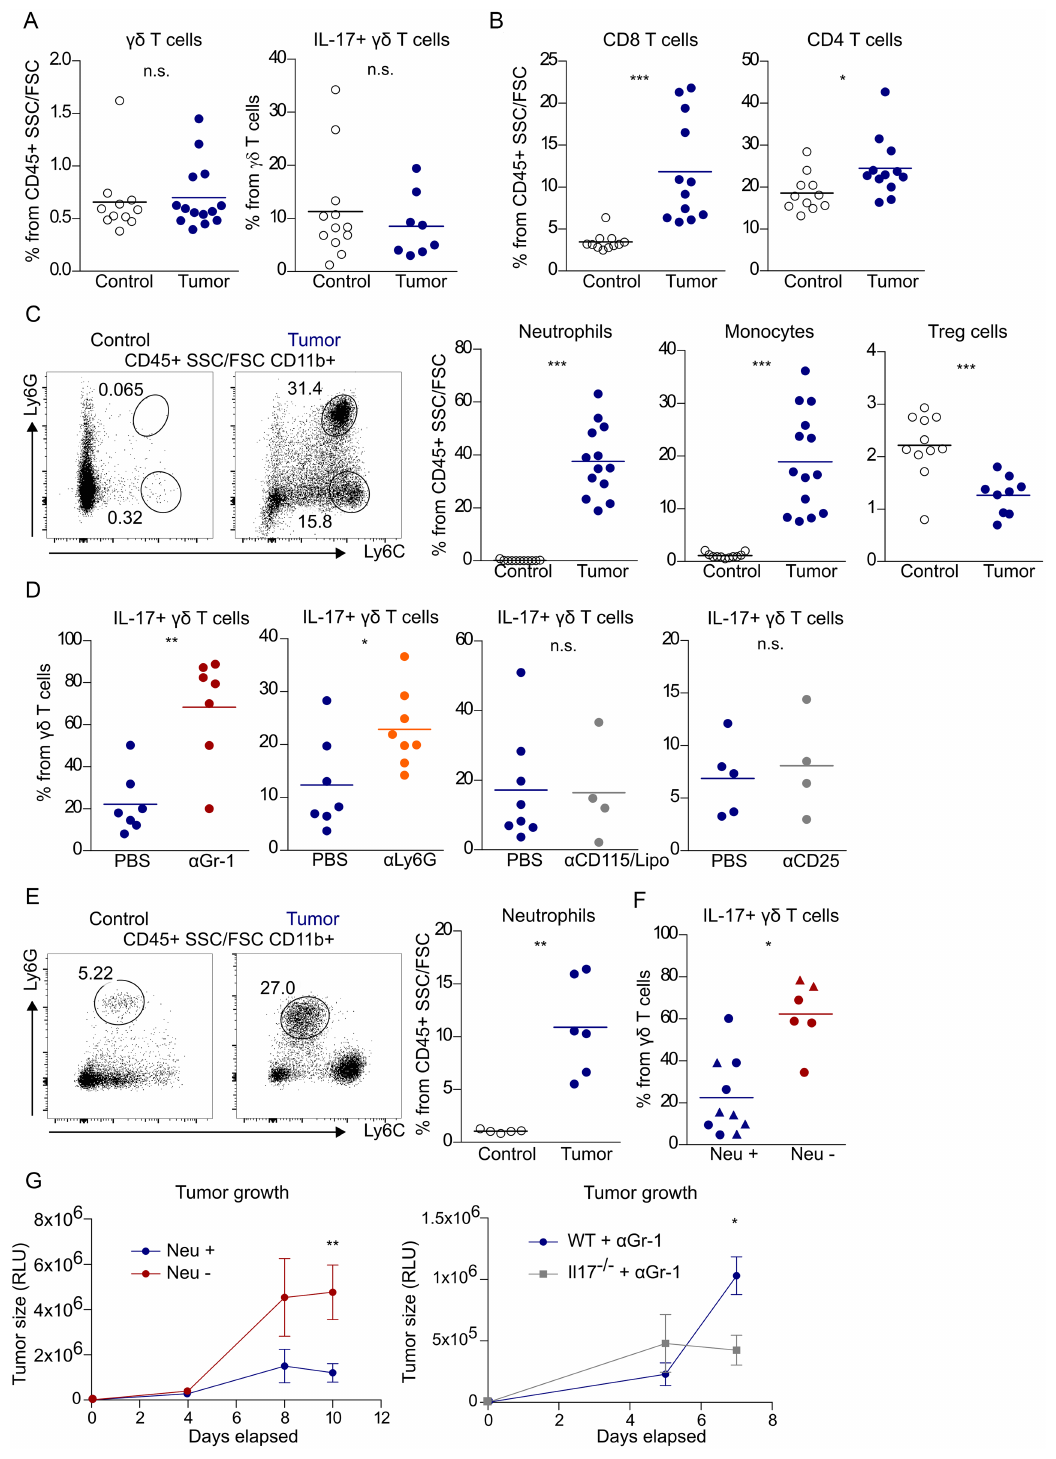
Fig 1. Tumor-associated neutrophils suppress γδ 17 T-cell responses. Frequency of (A) total and IL-17 + γδ T cells and (B) CD8 + and CD4 + T cells in the PEC of tumor-free and B16-F0 tumor-bearing mice. Data were pooled from four different experiments. (C) Representative FACS plots and summary of neutrophil, monocyte, and Treg cell frequency in the PEC of tumor-free and B16 tumor-bearing mice. Data were pooled from four independent experiments. (D) Frequency of IL-17 + γδ T cells in B16 tumor– bearing mice injected with vehicle (PBS) or mAb α Gr-1, α Ly6G, α CD115 + clodronate liposomes, and α CD25. (E)